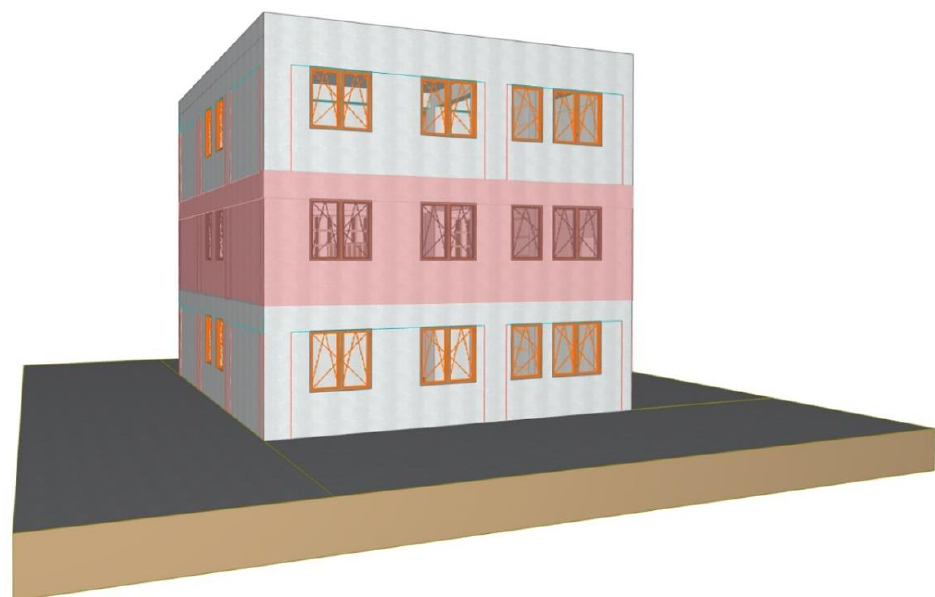
Figure 3. Three-dimensional view of the building with the apartment examined in evidence.